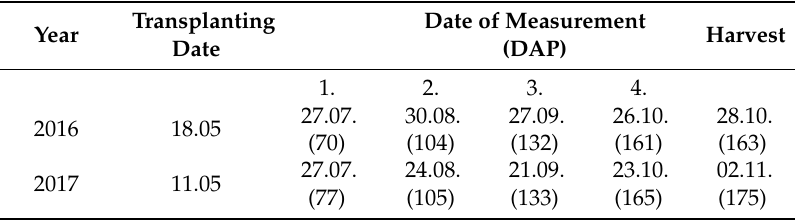
Table 2. Dates of transplanting, and the number of measurements and harvests in both experimental years, 2016 and 2017. Description includes the date and date of measurement (DAP) corresponding to all six tested